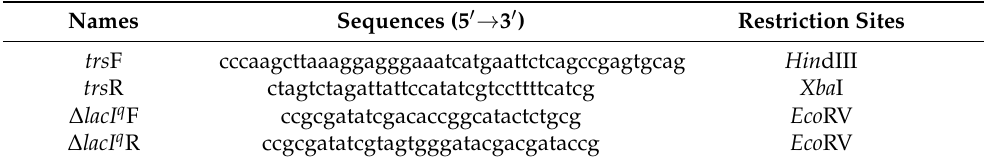
Table 2. Primers used in this